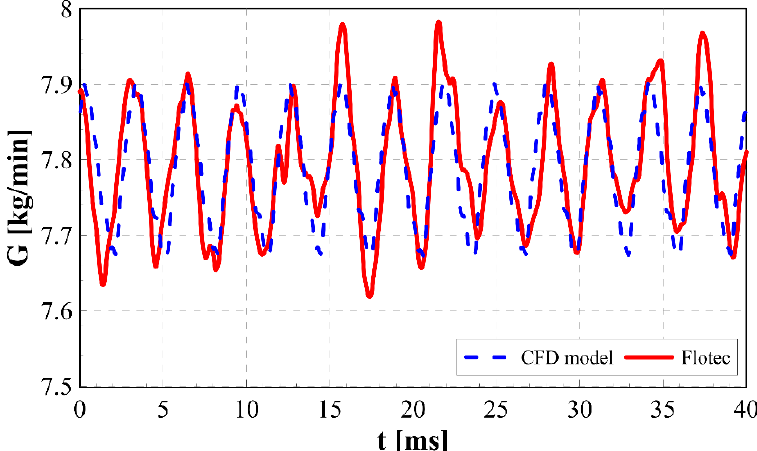
Figure 11. Comparison between the numerical and the experimental flowrates (1500 rpm, 9.5 bar— Configuration 3).